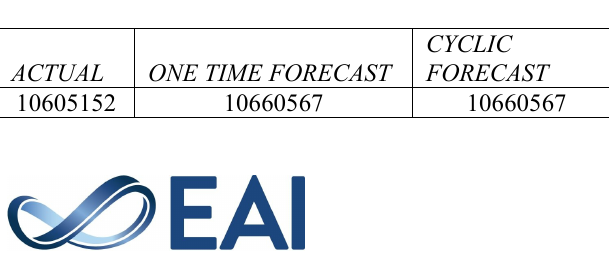
Table 1. Table showing Actual,One time forecast and Cyclic forecast